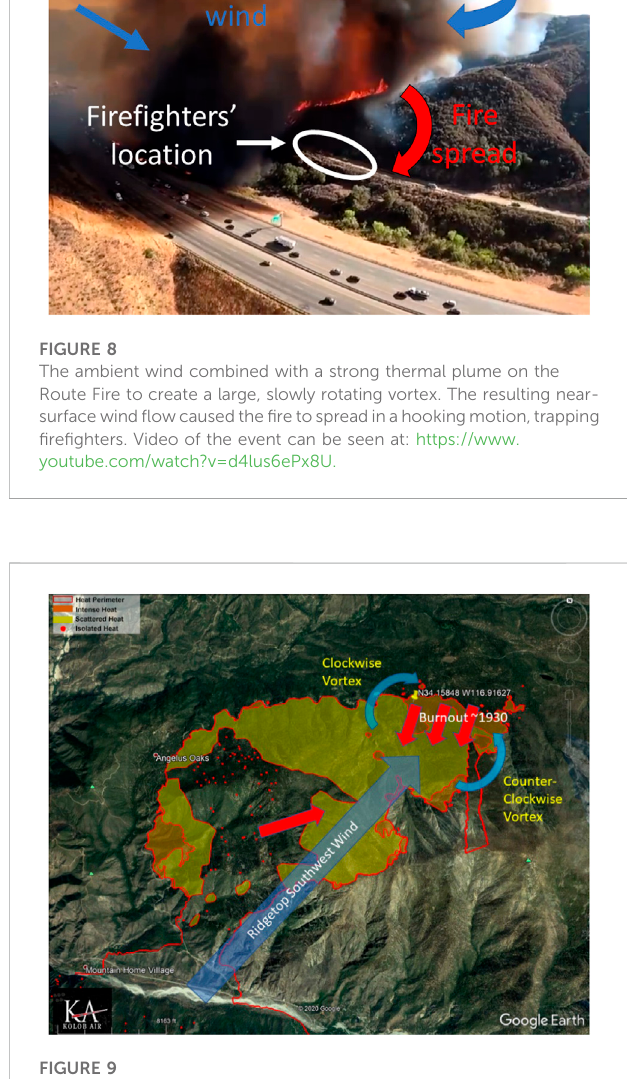
FIGURE 9 Wind, terrain, and a strong thermal plume caused by fi re fi ghter burn-outoperationsontheEldorado fi reresultedinapairoflarge-scale counterrotating vortices near the downwind side of the fi re. Strong, vortex-induced winds in this area increased fi re behavior, creating many spot fi res. This led to the entrapment and death of one fi re fi